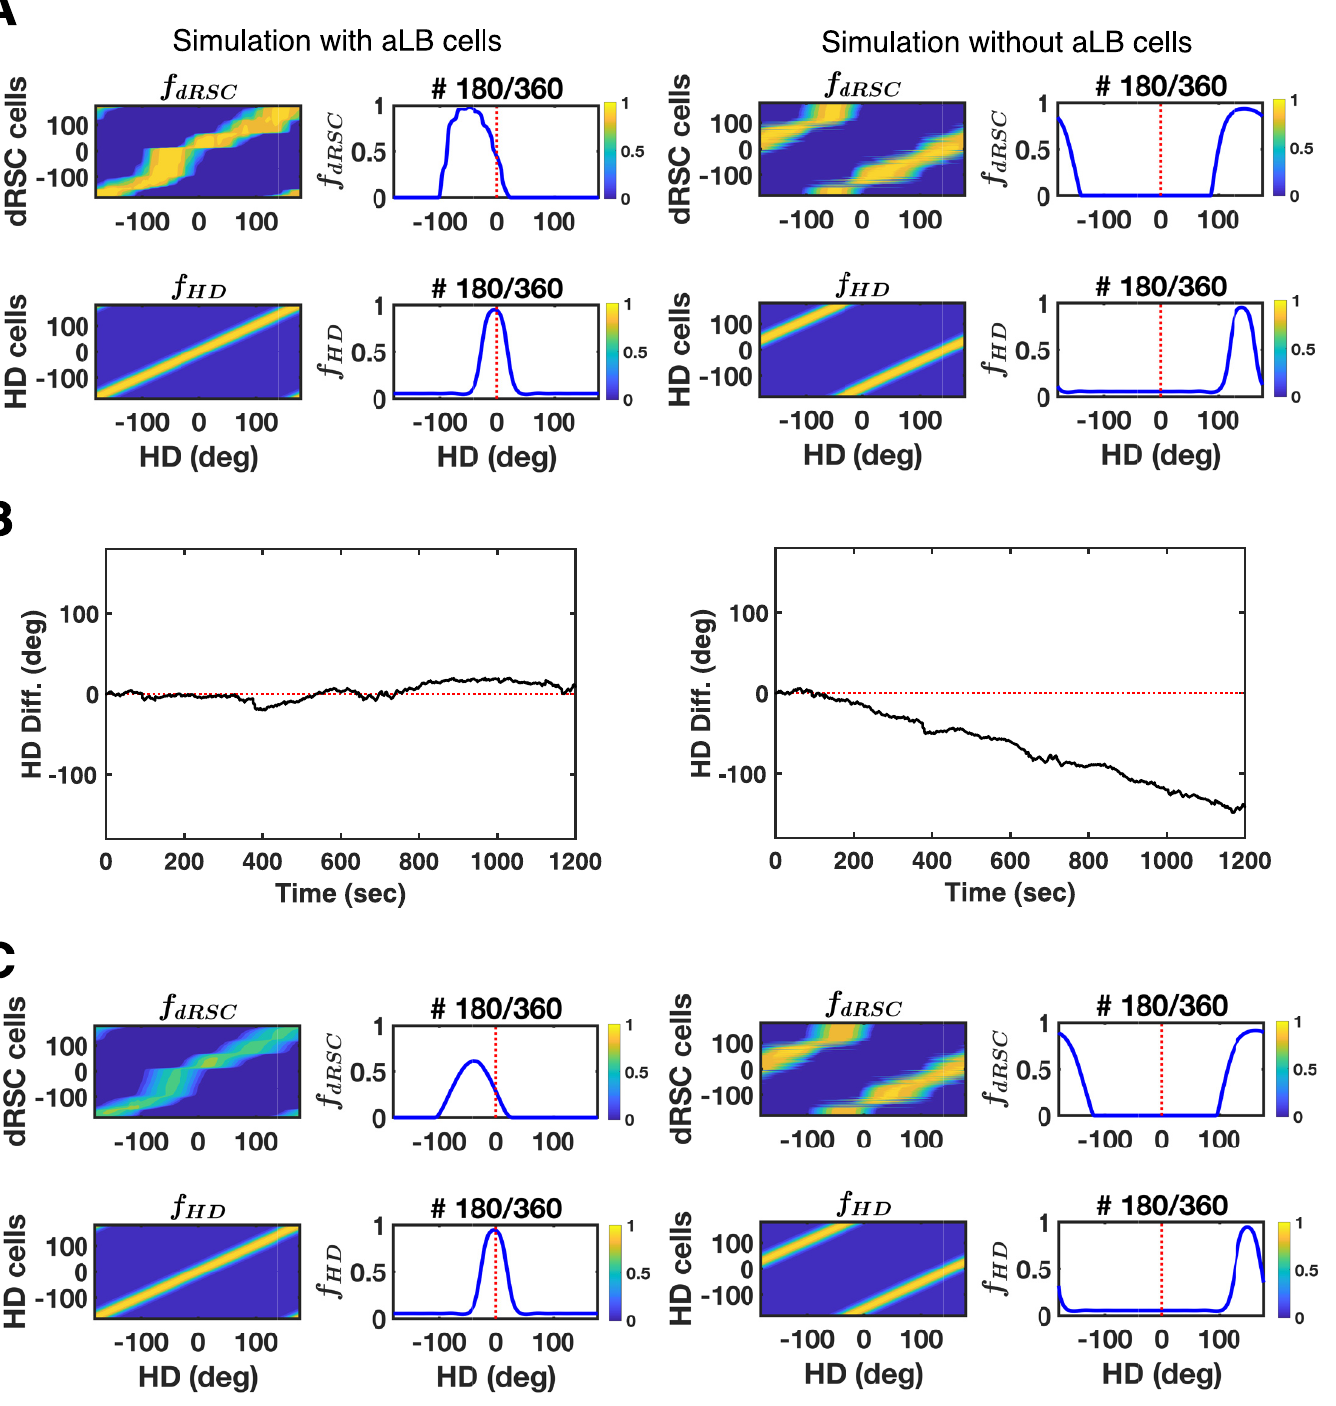
Fig 8. The retrieval utility of aLB cells under multi-environmental exploration similar to Fig 4. Simulations are conducted via our two-stage model (left, with aLB cells) and the alternative model (right, without aLB cells but rather a direct visual to dRSC Hebbian connection). (A) Global representations of dRSC cells (top) and HD cells (bottom) tested on the scenery in the final environment (Env. X). Red dashed lines stand for the center of initial firing fields. See the caption of Fig 4 for more details. (B) The difference between the actual HD and the HD representation over the whole 20-minute learning time. (C) Global representations of dRSC cells (top) and HD cells (bottom) tested on the sceneries in the first environment (Env. I), referring to new firing fields of dRSC and HD cells for retrieving the earliest scenery after learning across environments is complete. Abbreviations: Env.: Environment; dRSC: dysgranular retrosplenial cortex; HD: head direction; Diff.: difference; f : firing rate.